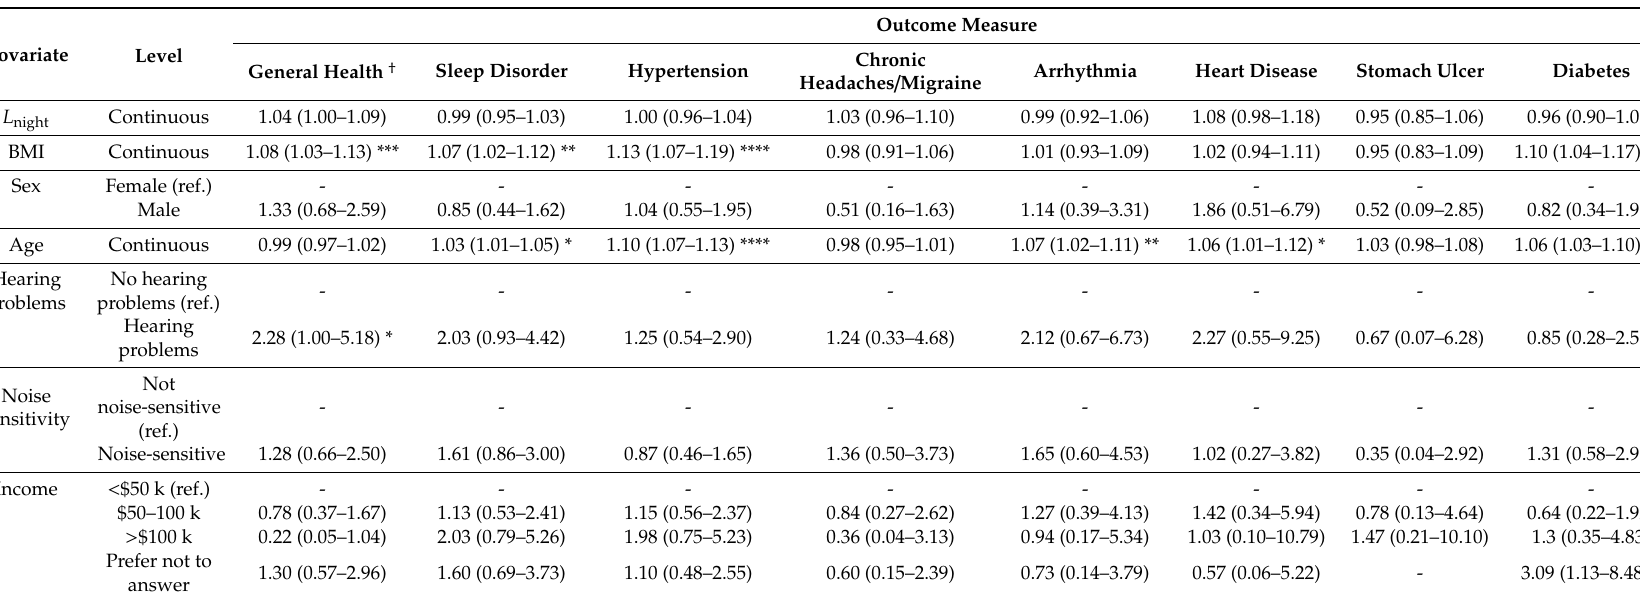
Table 7. Odds ratios (95% confidence intervals) from logistic regression models for general health and diagnosis of di ff erent health outcomes, adjusted for age, BMI, sex, hearing problems, noise sensitivity and